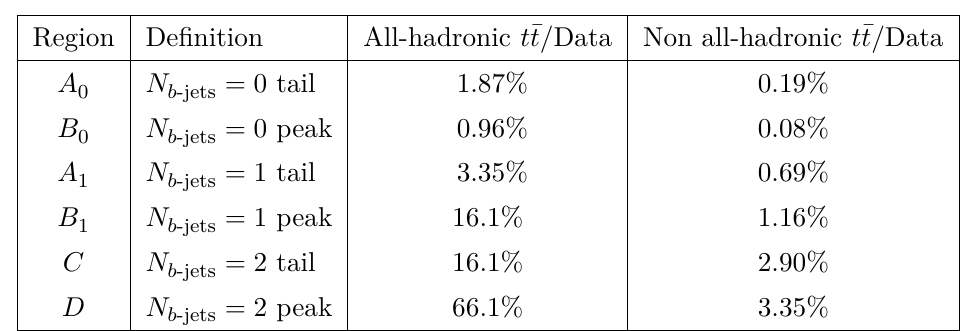
as defined in table t